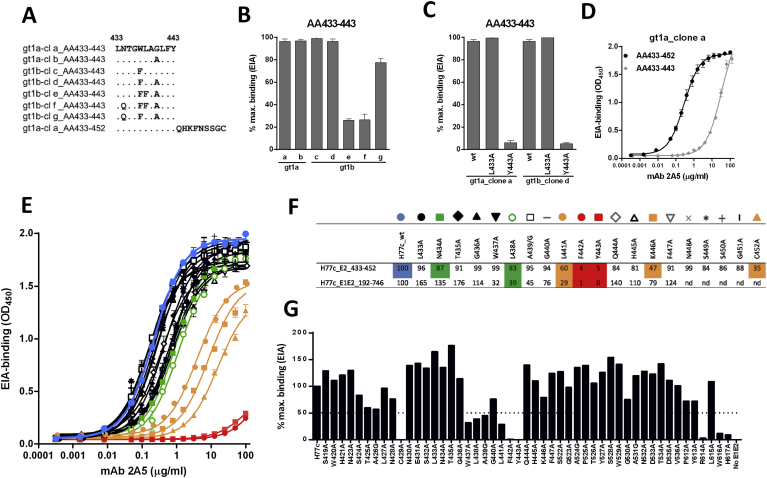
Epitope mapping of mAb 2A5. The binding pattern of mAb 2A5 was analyzed using gt1a- and gt1b-derived sequences, of which the E2 region spanning amino acids (AA)433–443 of the different clones (cl) is shown (A). After incubation with surface-attached peptides, bound antibodies were detected with an HRP-conjugated anti-human secondary antibody. The 2A5-binding pattern was analyzed using mAb (50 μg/mL) and peptides spanning AA-region 433–443, derived from naturally occurring gt1a (clone a-b) and gt1b (clone c-d) isolates (B), and A-substituted peptides (L433A, Y443A) from gt1a_clone a and gt1b_clone d (C). Binding was normalized to the best binding peptide (100% binding). (D) To elaborate on the length of the epitope, the efficiency of 2A5-binding was compared between peptides covering region AA433-443 and peptides including an additional upstream sequence (AA433-452), all derived from gt1a_clone a. (E) To further elaborate on 2A5-anchor residues within the region of interest (AA433-452), the binding efficiency was compared between peptides derived from the prototype isolate H77c and their A-substituted counterparts. The corresponding color-codes, representing the different A-substituted sequences, and the % binding relative to native H77c at 10 μg mAb/mL are shown in (F). (G) To confirm these results and to reveal additional contact residues for mAb binding, epitope mapping was done using E1E2 proteins of the H77c isolate with A-substitutions in 3 regions (AA419-447, AA522-536 and AA612-617). 2A5-binding to full-length native and mutated E1E2 cell lysates was analyzed. Results represent the % binding relative to E1E2_H77c at 10 μg mAb/mL (F, G).